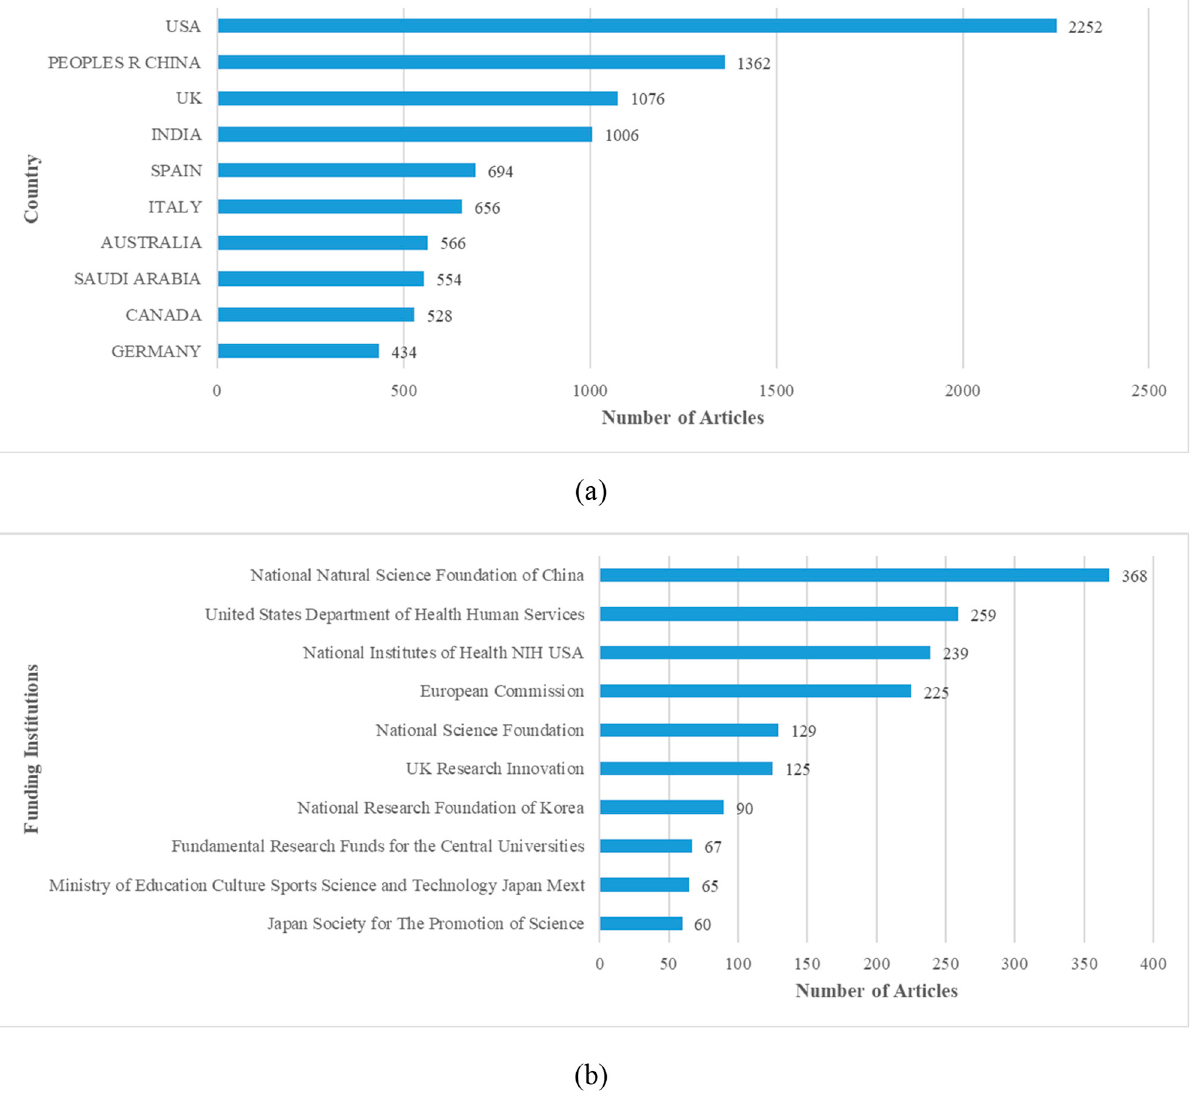
Figure 2. Top 10 literature sources of ( a ) countries/regions and ( b ) funding institutions.